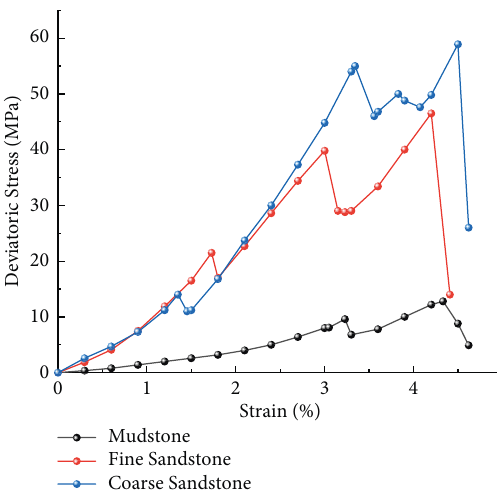
Figure 10: Stress evolution of specimens with different lithologies. Figure 11: Variation curve of strength peak and residual strength of specimen with lithology.